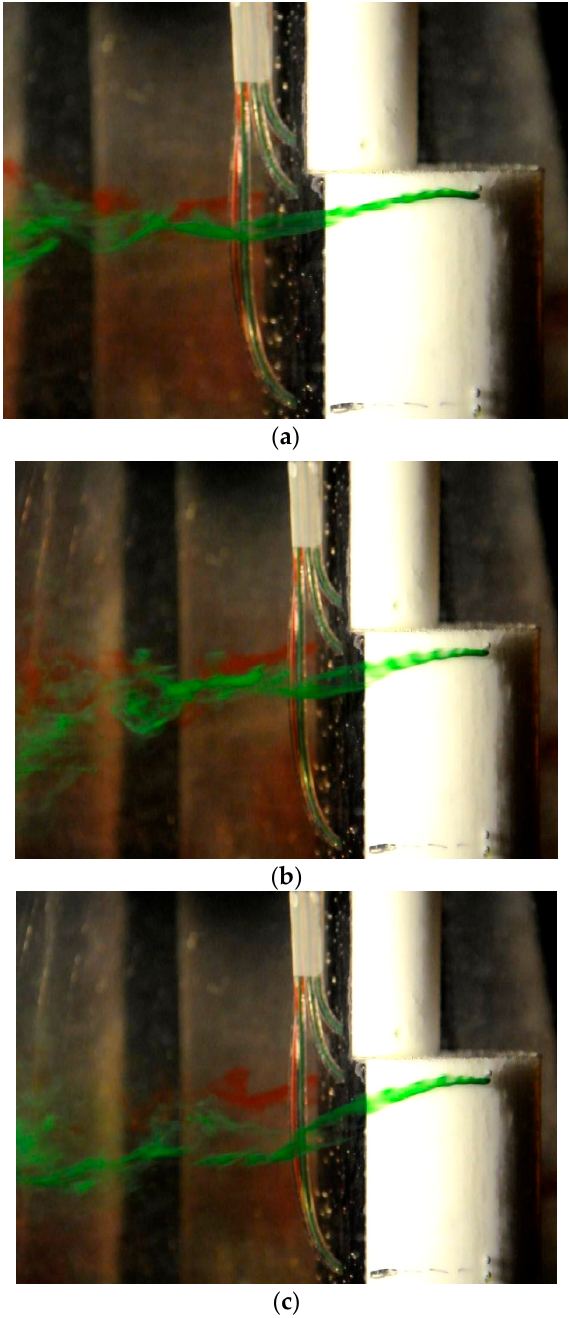
Figure 5. Wake structures around step cylinder at z / D = − 0.5; ( a ) [ t = 0]; ( b ) [ t + 1]; ( c ) [ t + 1 + 1].